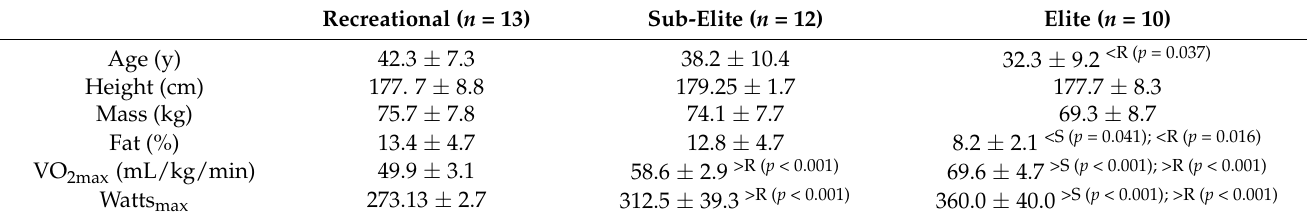
Table 1. Summary of the characteristics of the